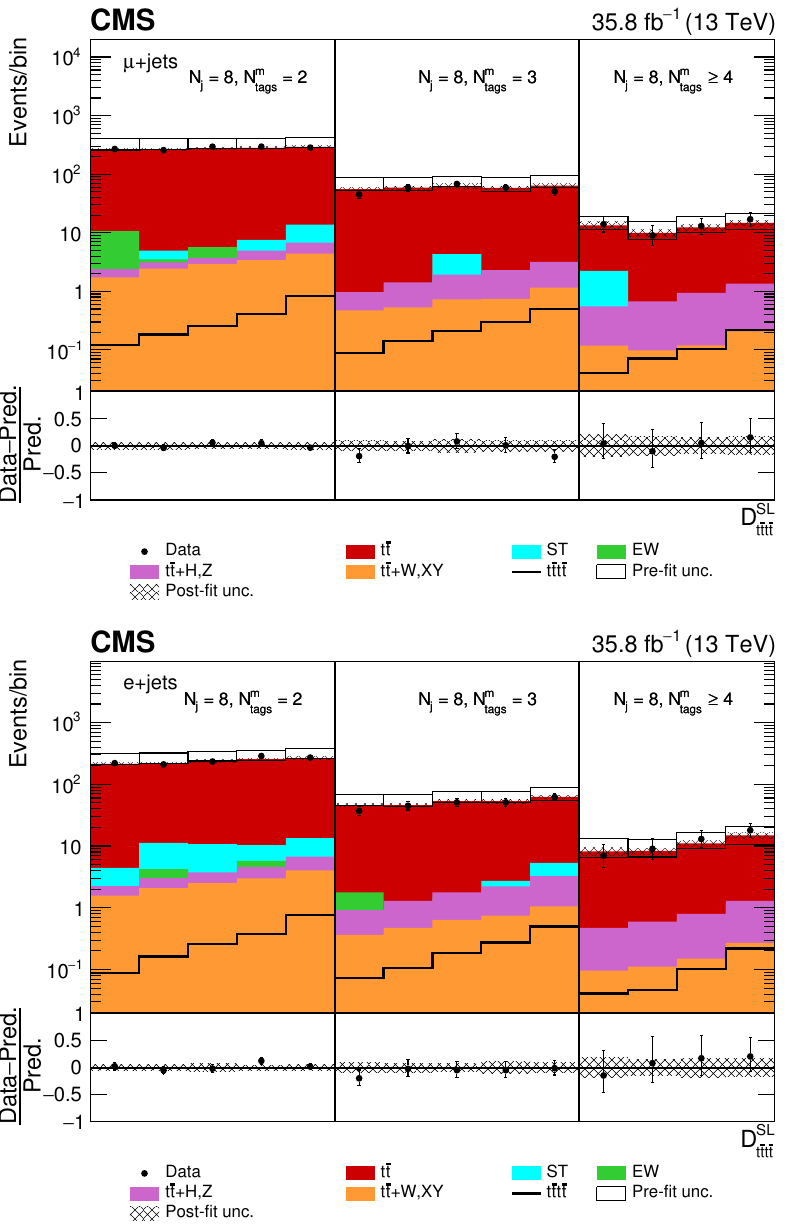
Figure 7 . Post-(cid:12)t D SL distribution in the (upper row) single-muon and (lower row) single- tttt electron channels for events satisfying baseline single-lepton selection and N = 8, N m = 2, 3, j tags (cid:21) 4. Non-uniform binning of the BDT discriminant was chosen to achieve approximately uniform distribution of the tt background. Dots represent data. Vertical error bars show the statistical uncertainties in data. The post-(cid:12)t background predictions are shown as shaded histograms. Open boxes demonstrate the size of the pre-(cid:12)t uncertainty in the total background and are centered around the pre-(cid:12)t expectation value of the prediction. The hatched area shows the size of the post-(cid:12)t uncertainty in the background prediction. The signal histogram template is shown as a solid line. The lower panel shows the relative di(cid:11)erence of the observed number of events over the post-(cid:12)t background prediction.